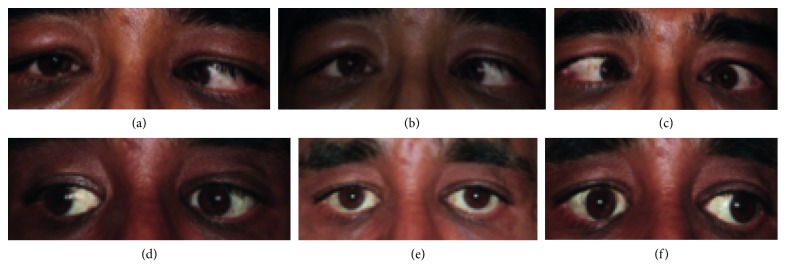
Images showing patient 3 before surgery in rightgaze (a), primary position (b), and leftgaze (c). The patient 4 years after bimedial rectus recession with Tutopatch in rightgaze (d), in primary position (e), and in leftgaze (f). Considering the large recession of 17.5 mm per medial rectus muscle, the patient shows excellent motility with some restriction of adduction on the right eye > left eye.